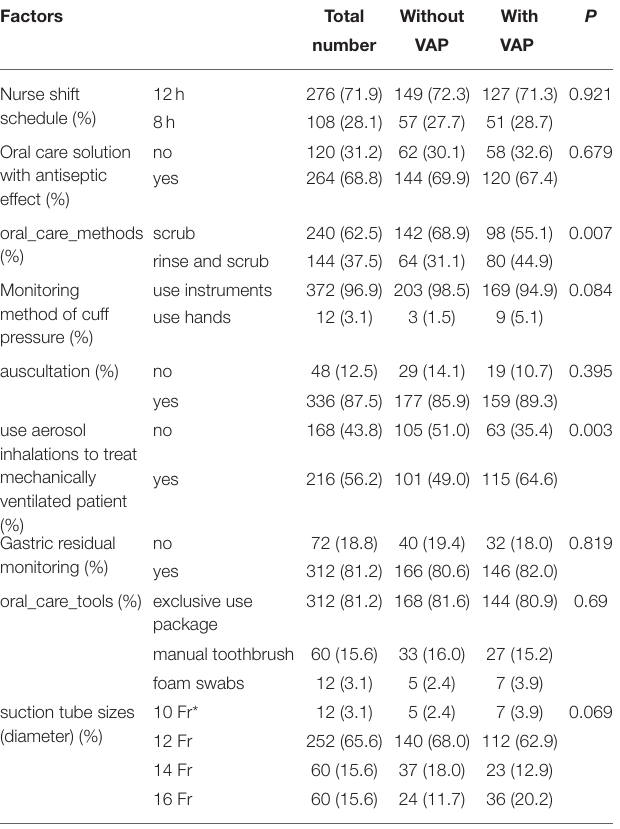
TABLE 2 | Nursing human resources and nursing operations. Factors